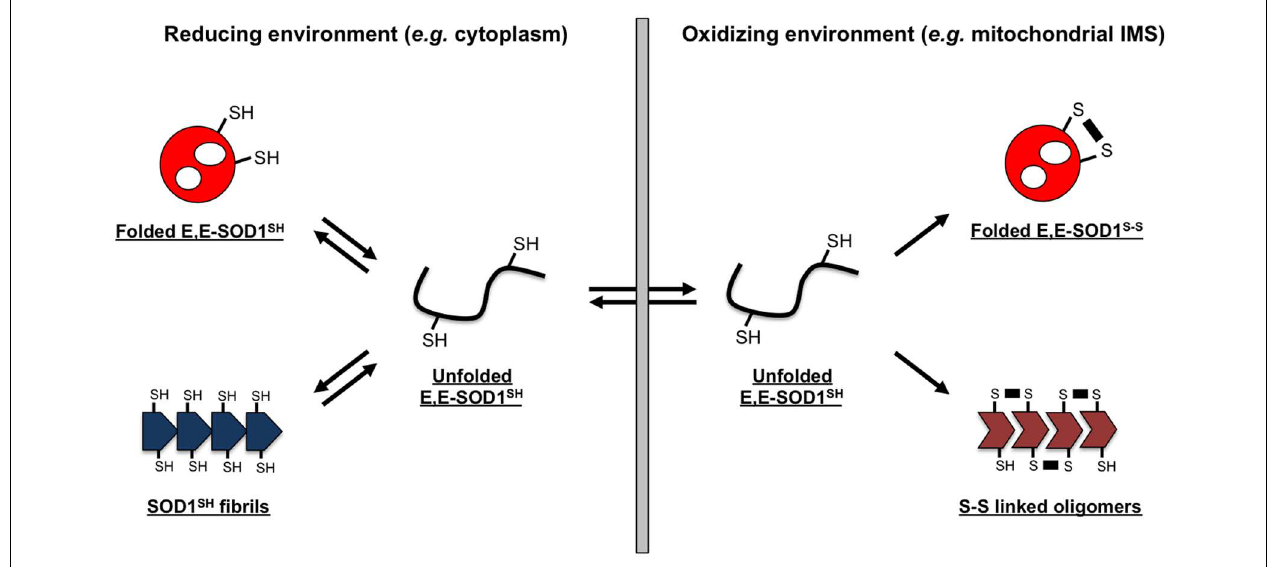
Many fALS mutations are considered to destabilize the structure of E,E-SOD1 SH , increasing the fraction of misfolded state. In such a situation, oxidizing environment favors the formation of SOD1 oligomers cross-linked via abnormal disulfide bonds. Depending upon redox environment where SOD1 exists, several distinct forms in SOD1 aggregates are hence